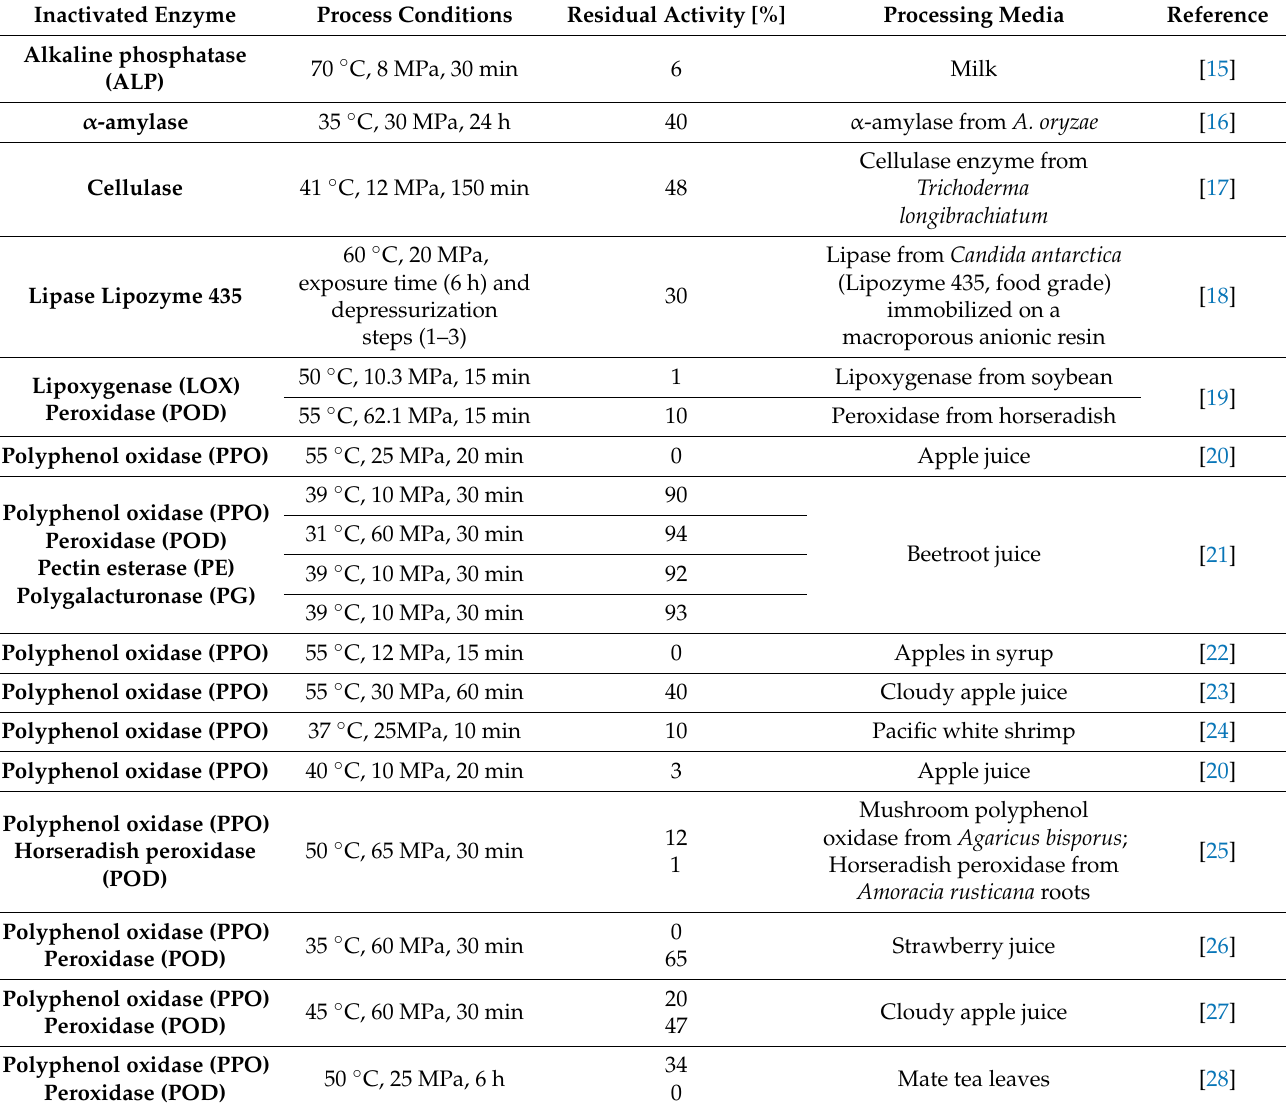
Table 1. Examples of food enzyme inactivation using scCO 2